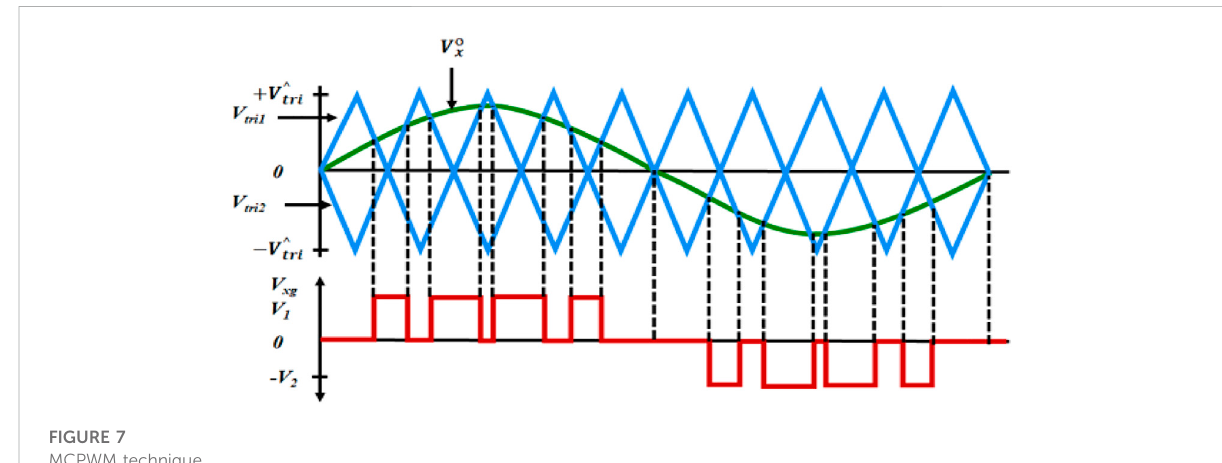
FIGURE 7 MCPWM technique.